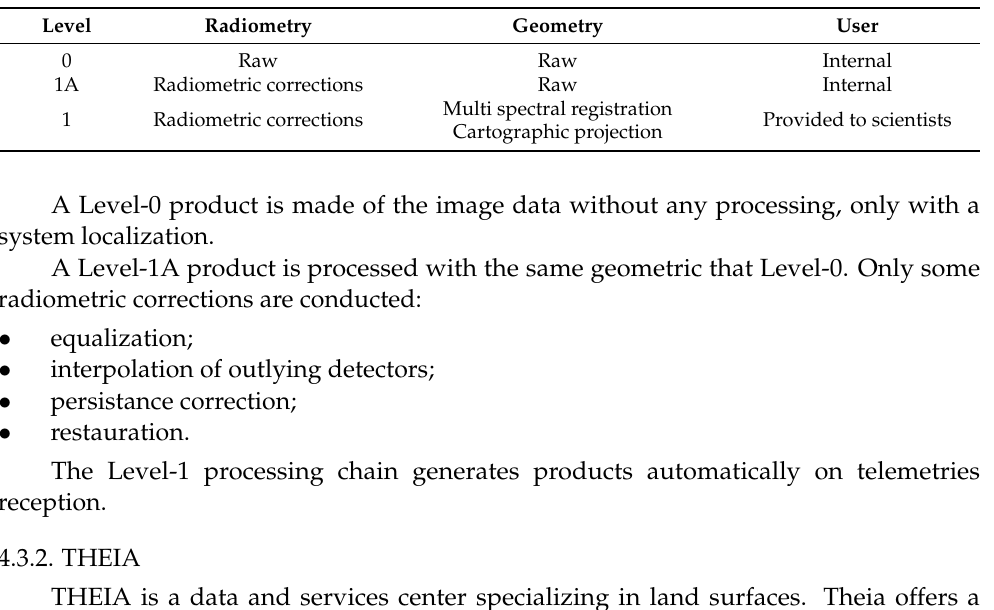
Table 1. Characteristics of VENμS products levels.